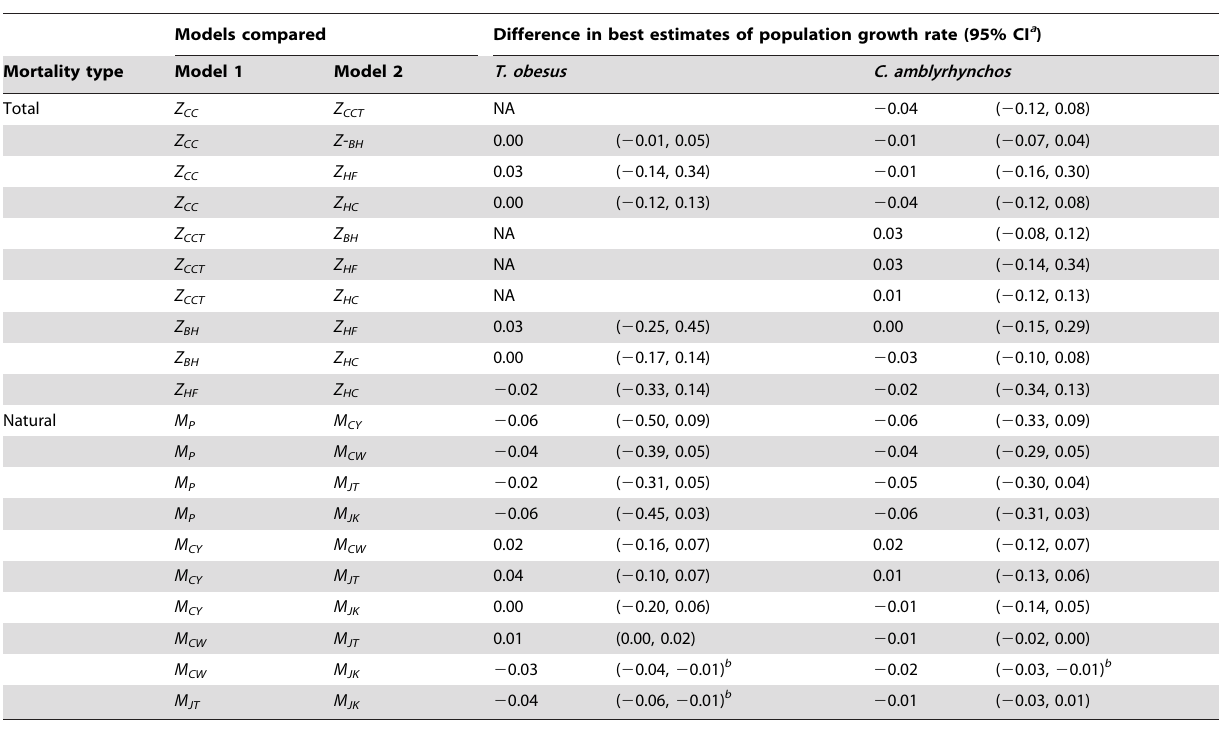
Table 1. Pair-wise comparisons of population growth rate estimates (model 2 – model 1) obtained from different mortality models, including 95% bootstrap bias-corrected, accelerated (BCa) confidence